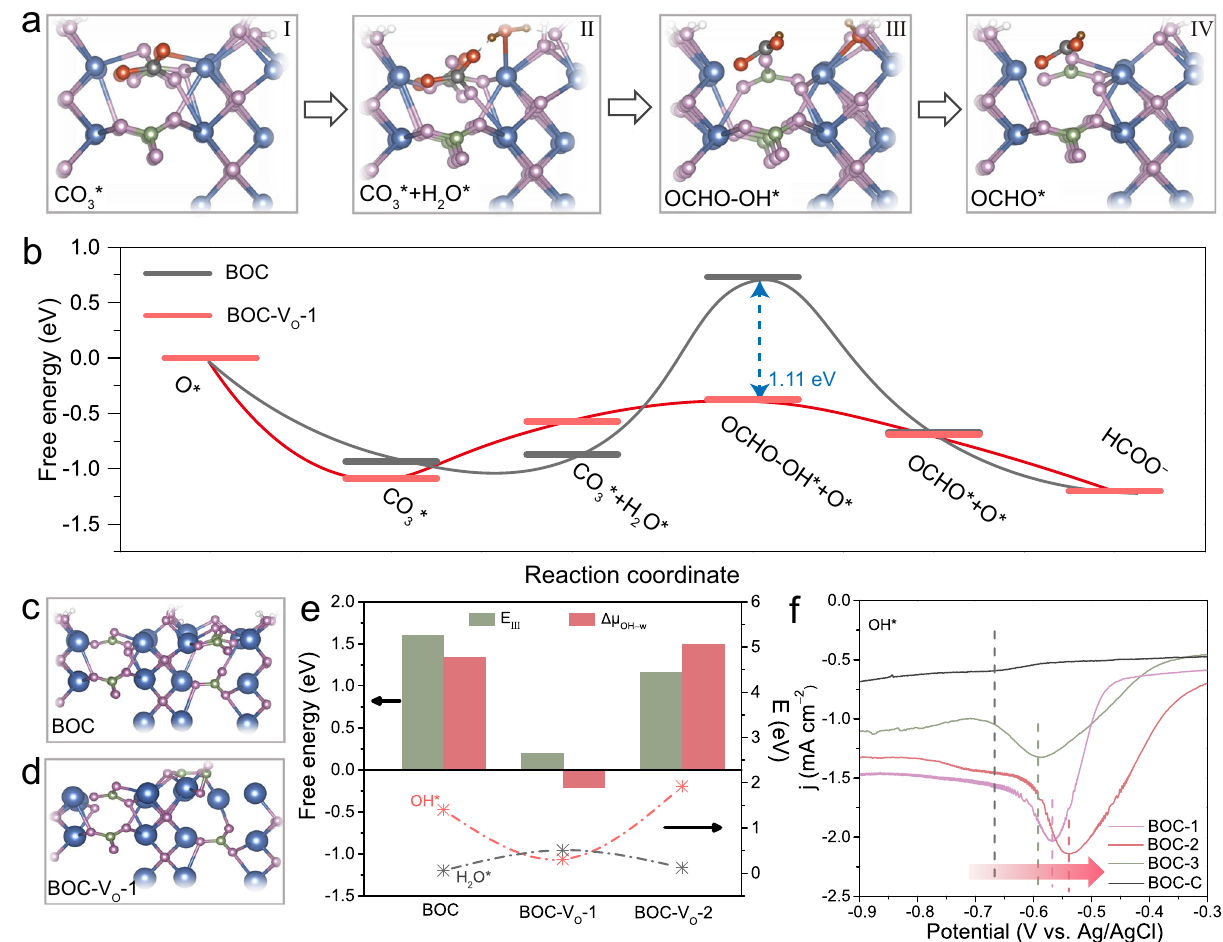
b The free energy plots for BOC with and without V O along the reaction pathway. c , d ThebasiccomputedmodelsofnormalBOCandBOCwithV O onsurface(BOC- V O − 1), respectively. e The free energy of step III, Δμ OH − w , the adsorption energy of OH* and the adsorption energy of H 2 O* for BOC with different V O contents. f LSV curves of BOC with different V O concentrations in Ar-saturated 0.1M